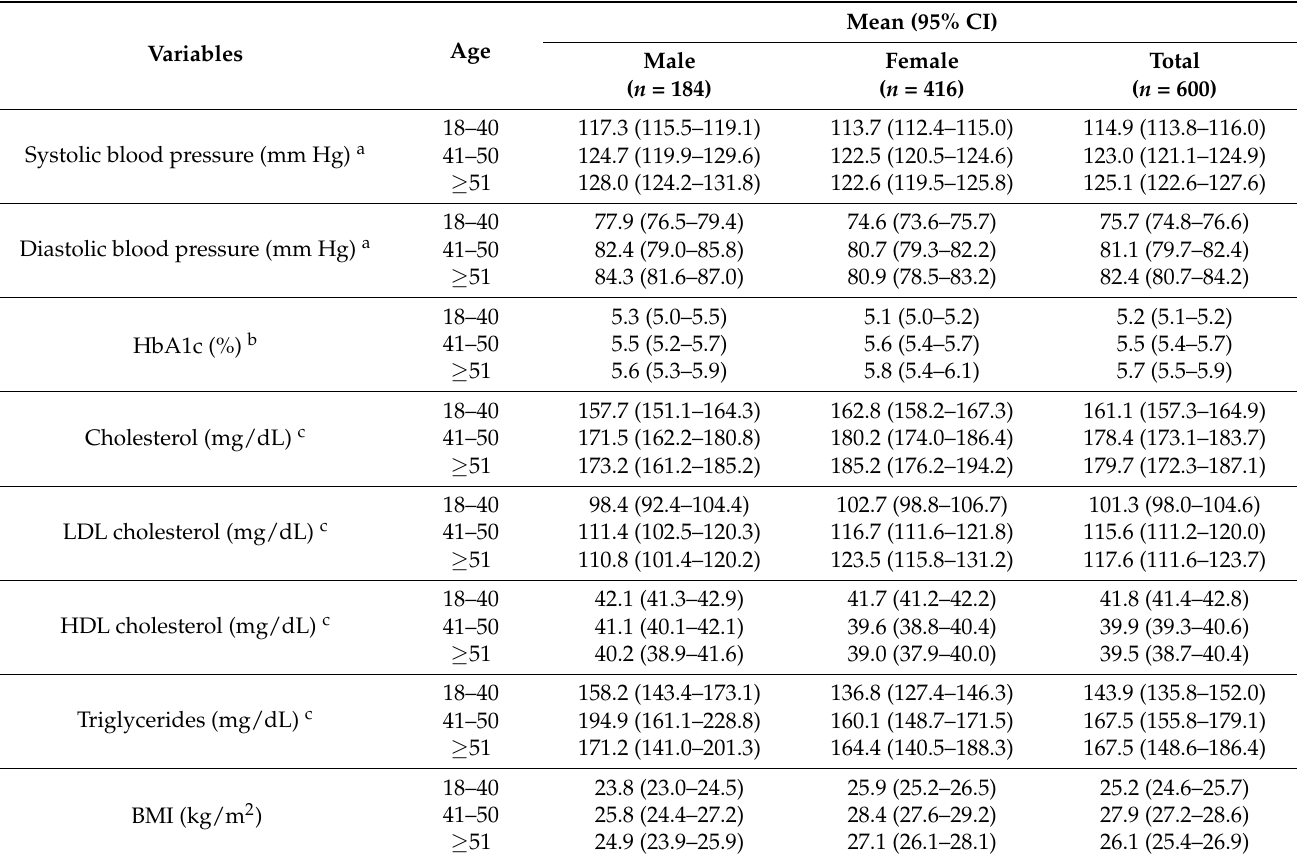
Table 3. Distribution of mean levels of biomedical indicators related to non-communicable diseases by age and gender among schoolteachers in Afghanistan ( n =